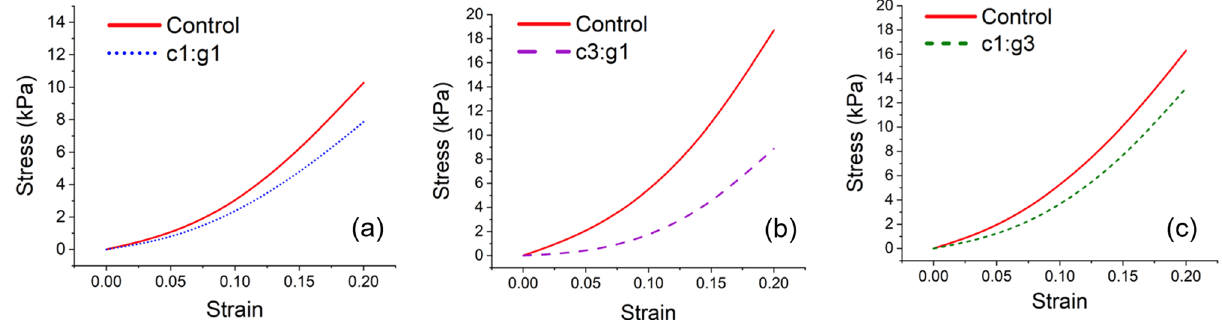
Figure 1. Stress–strain analyses of healthy and degraded cartilage samples before and after treatment with enzyme concentrations of c1:g1 ( a ), c3:g1 ( b ), and c1:g3 ( c